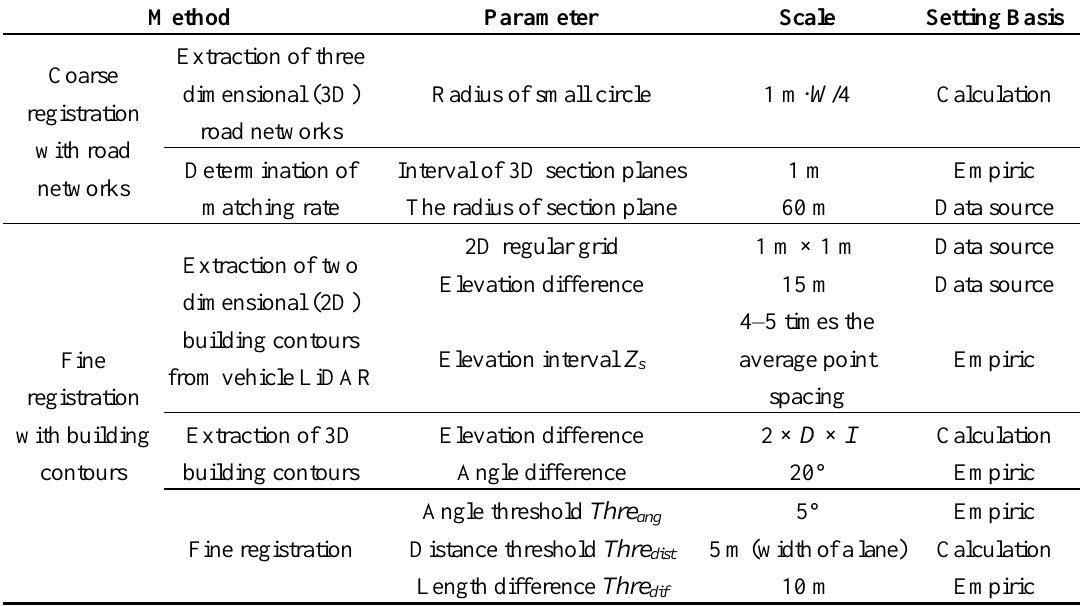
Table 1. Key parameters used in the proposed